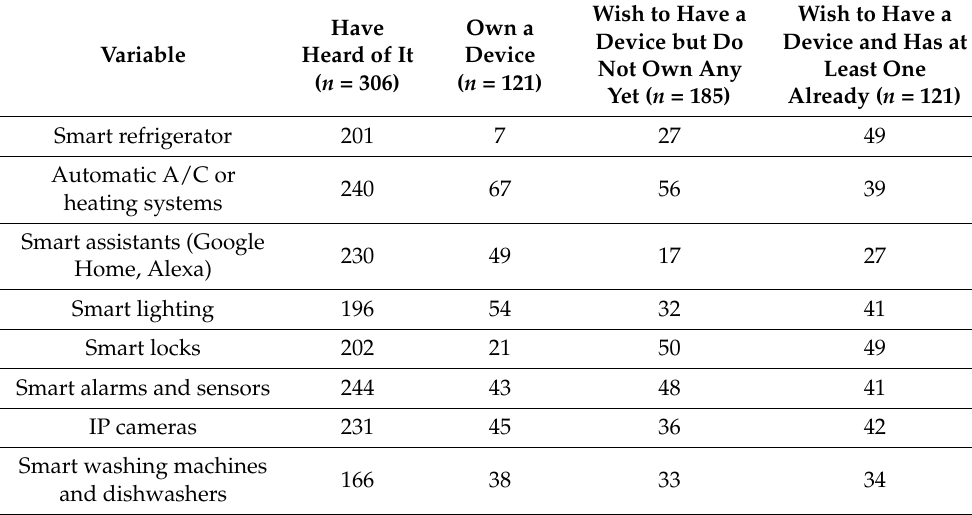
Table 2. Familiarity with IoT devices and use.